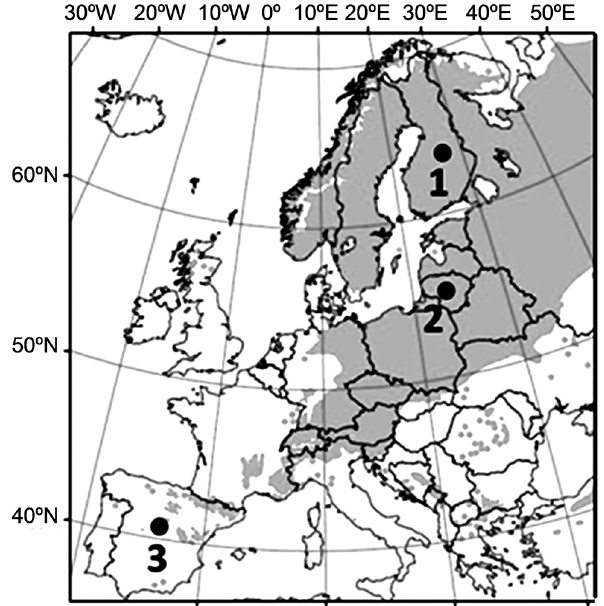
Figure 1. Location of the Finnish (1), Lithuanian (2) and Spanish (3) populations used in the study.